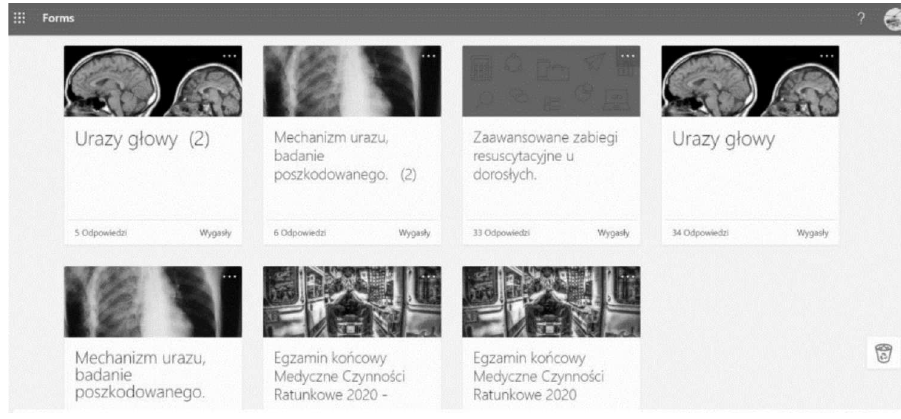
Figure 5. Tests in Forms from the Office 365